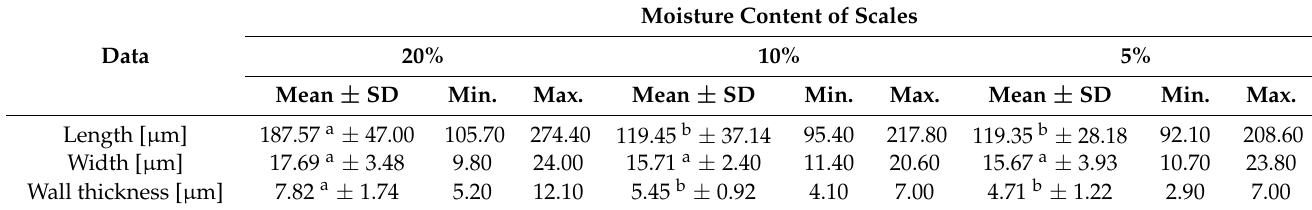
Note: a,b —homogeneous